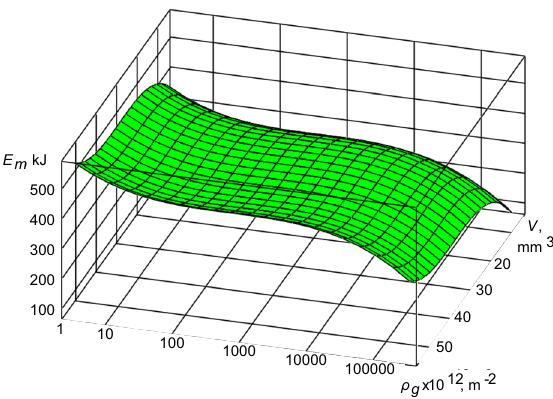
Figure 2. The energy-mass transfer in the TS “crankshaft-insert” for the operating conditions of diesel engine 10D100 during the self-organization processes.